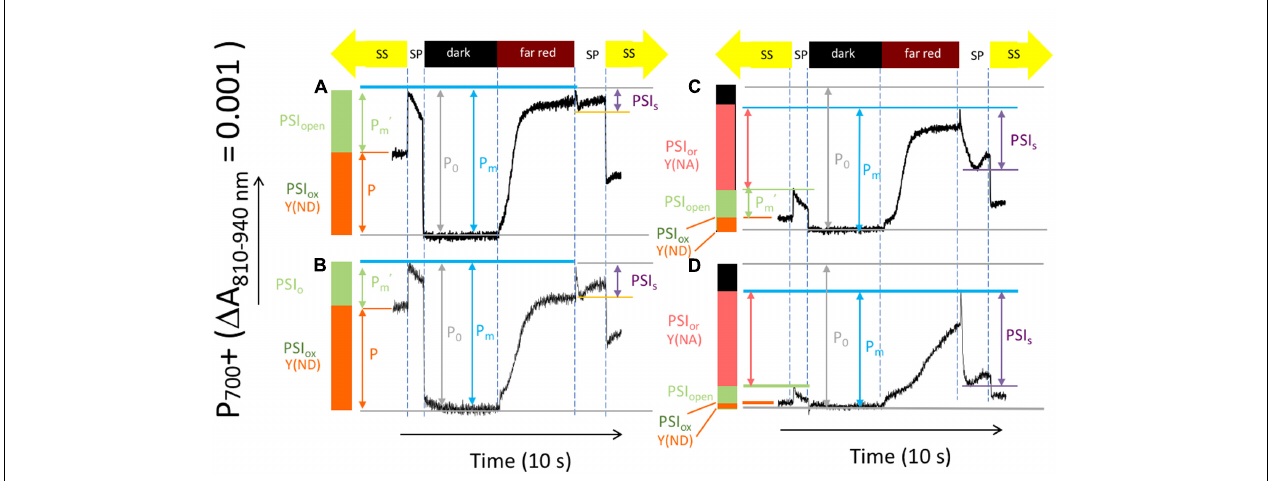
FIGURE 4 | Light induced P 700 + absorbance changes reflecting the activity and redox state of PSI centers. Attached leaves of Col-0 (A,B) , and cfq (C,D) under ambient (A,C) and 50 ppm CO 2 (B,D) . Absorbance traces (at 810–940 nm) were taken during a series of illumination conditions, as illustrated in the timelines at the top of the graphs: (1) the steady-state actinic illumination for 30 min at 300 µ mol photons · m − 2 · s − 1 (labeled ‘SS’ at the top); (2) application of a ∼ 1 s intense light pulse ( > 10,000 µ mol photons · m − 2 · s − 1 , labeled ‘SP’) to saturate PSI photochemistry; (3) a 5 s dark period to allow all P 700 + to become reduced (‘dark’); (4) a 5 s period of illumination with far red light ( > 730 nm), which preferentially excites PSI over PSII (‘far red’), was given to slowly oxidize the PSI donors and acceptors; (5) a 2-s saturating light pulse to achieve near full oxidation of P 700 (‘SP’ after ‘far red’); (6) return to steady-state illumination